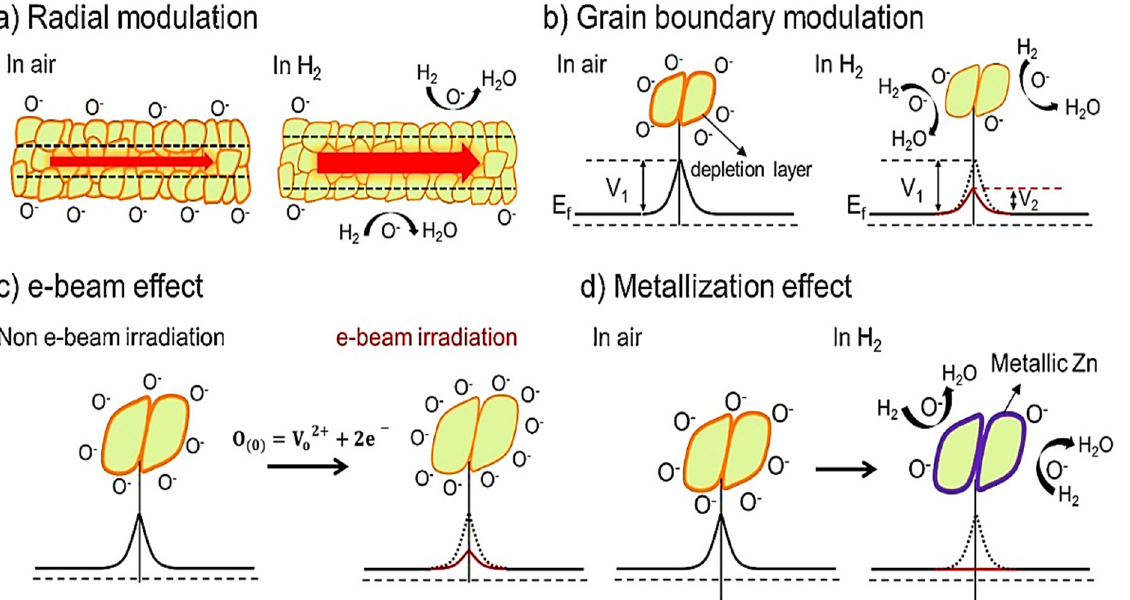
Figure 26. Schematic of the H 2 -sensing mechanism of the e-beam-irradiated ZnO NF sensor. ( a ) Radial modulation, ( b ) grain boundary modulation, ( c ) effect of e-beam, and ( d ) effect of ZnO metallization. Reproduced from [127] with the permission of Elsevier.